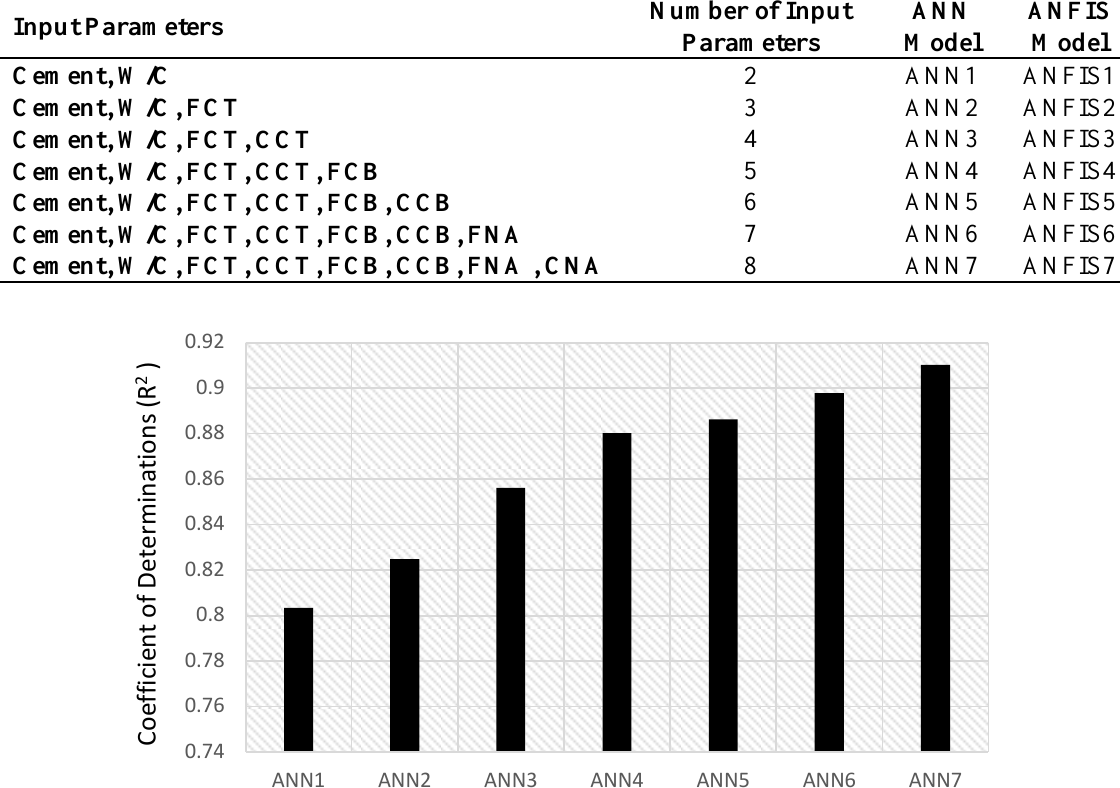
Fig. 18. Coefficient of Determinations (R 2 values) for ANN1, ANN2, ANN3, ANN4, ANN5, ANN6, and ANN7.